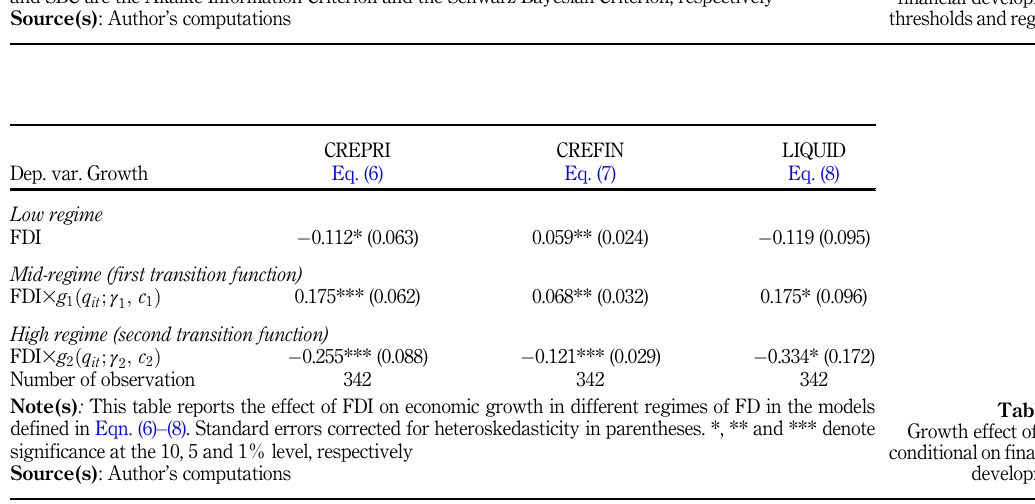
Table 4. Growth effect of FDI